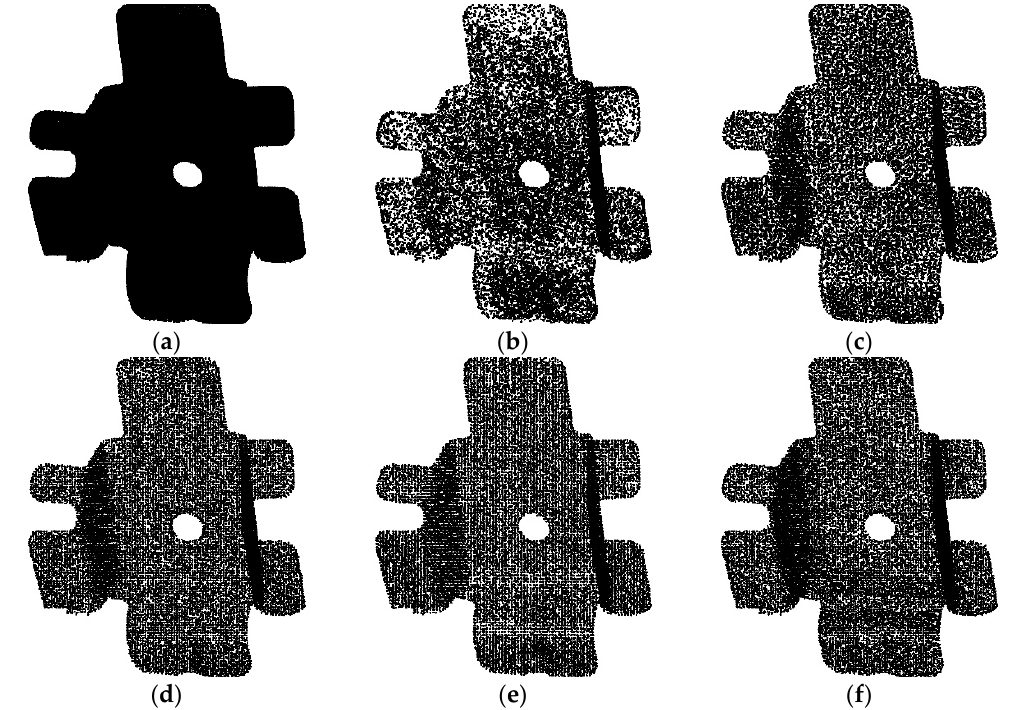
Figure 6. Point cloud simplification experiment. ( a ) is the initial point cloud data, ( b ) is the calculation result of random sampling, ( c ) is the calculation result of curvature sampling, ( d ) is the calculation result of grid sampling, ( e ) is the calculation result of octree-based sampling, and ( f ) is the calculation result of our sampling algorithm in this paper.